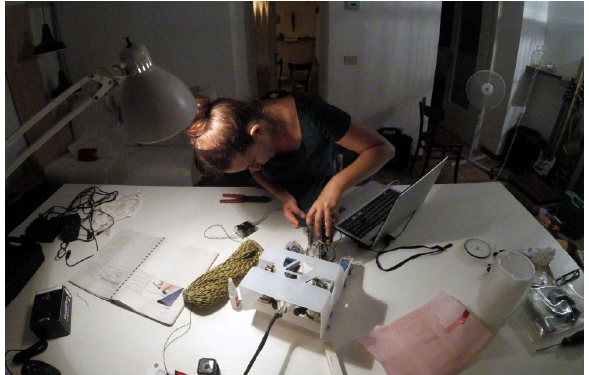
Figure 1. One of the phases of assembling the ROV.